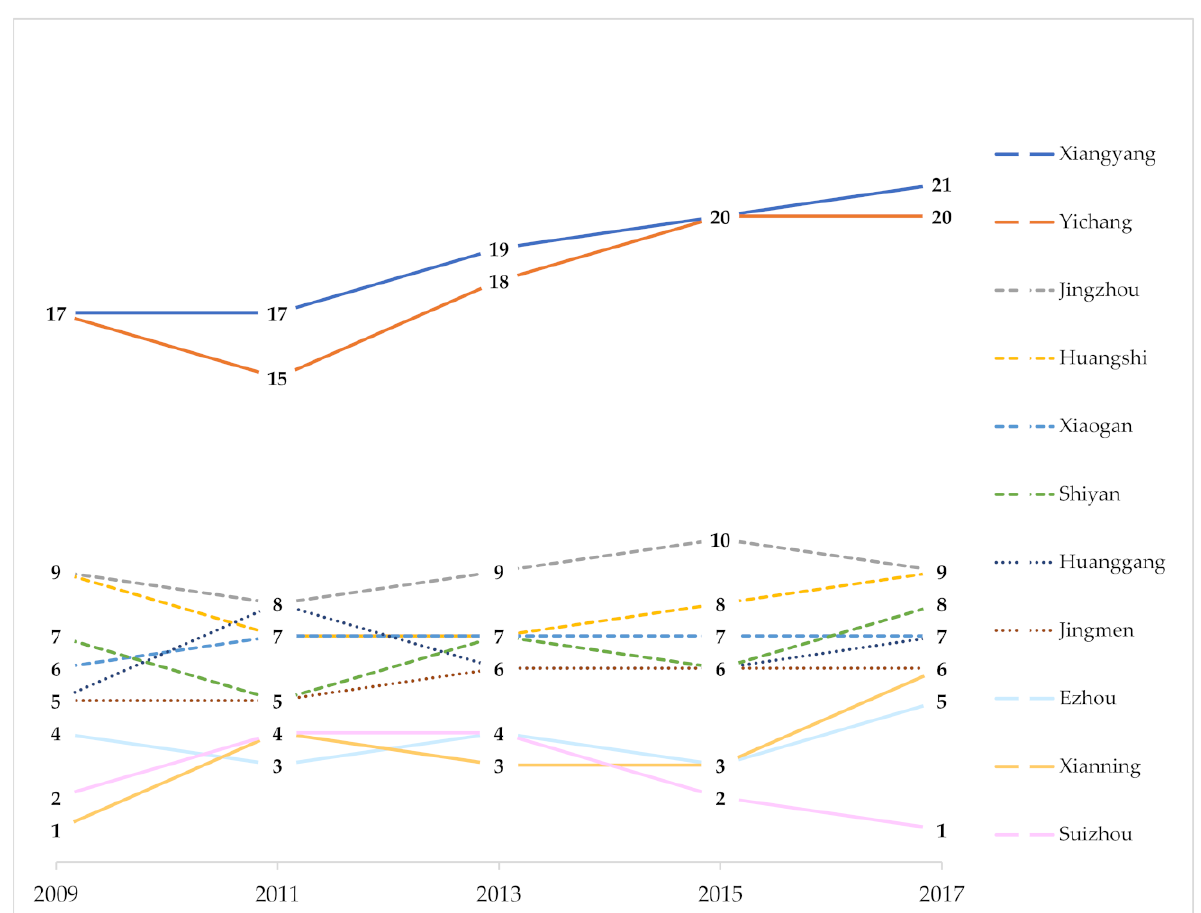
Figure 5. Map of changes in urban competitiveness in Hubei Province (except